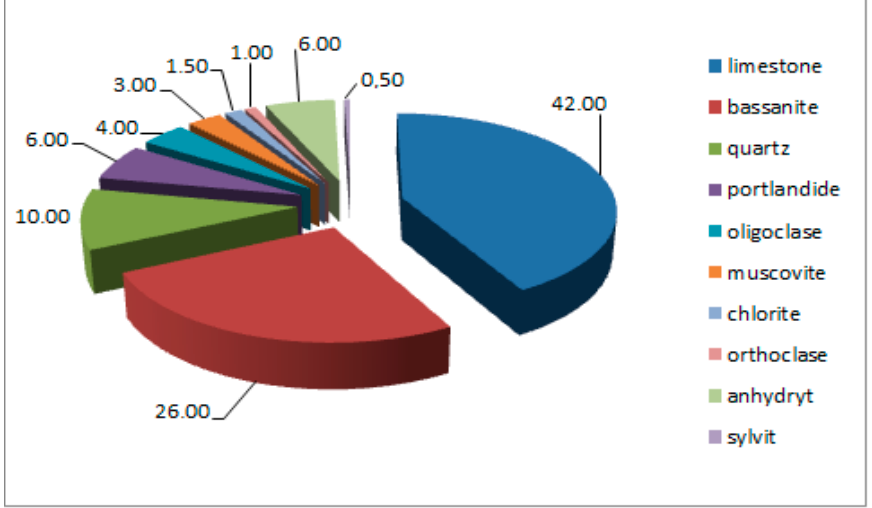
Figure 2. Mineralogical analysis of solids sample (Stage 2) acquired from waste sludge water [%].